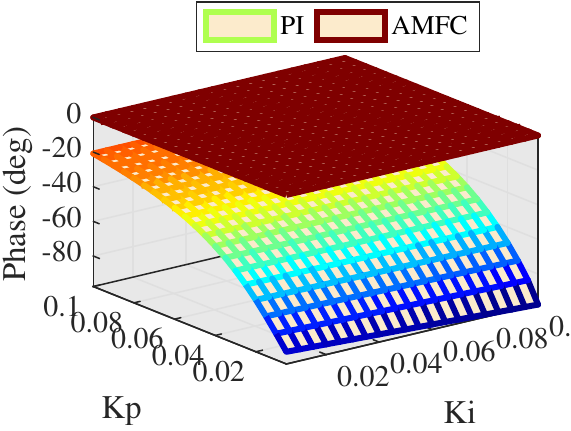
Figure 12. Phase comparison between PI and AMFC α =